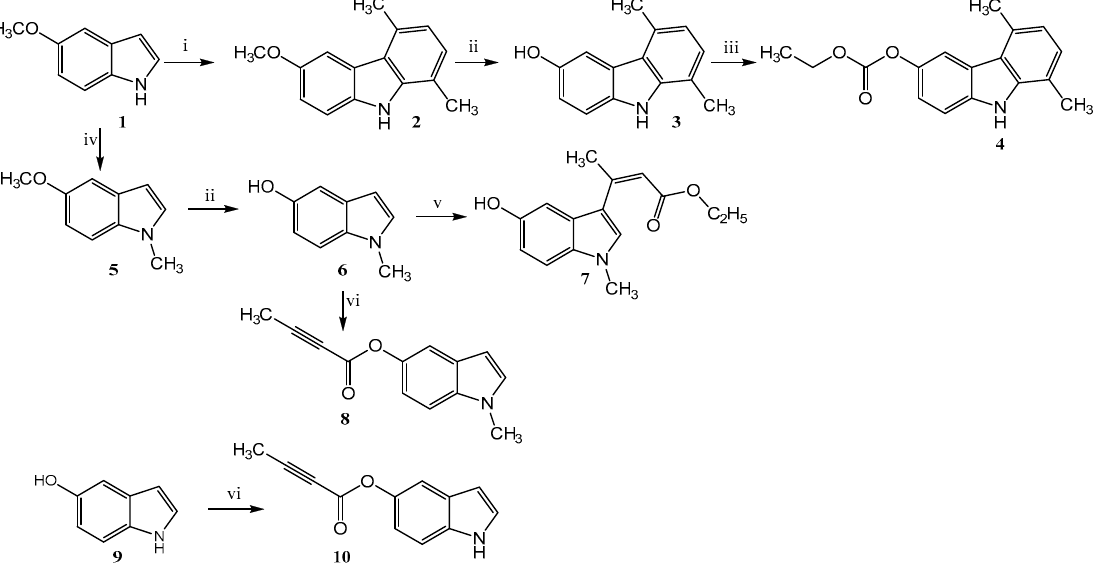
Figure 2. Reagents: (i) acetonylacetone, p -TSA, ethanol, reflux, 6 h; (ii) anhydrous pyridine hydrochloride, reflux, 2 h; (iii) ethyl chloroformate, NaOH solution 1N, acetone, reflux, 4 h; (iv) NaH, CH 3 I, DME, 25 °C; (v) ethyl acetoacetate (1 mol), indium (III) chloride, reflux, 2 h; (vi) but-2-ynoic acid, DCC, DMAP, CH 2 Cl 2 /DMF (10:1), r.t. 2 h.